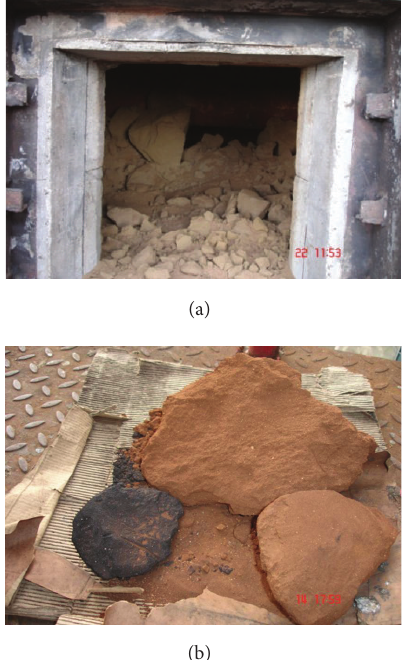
Figure 8: Cyclone outlet standpipe